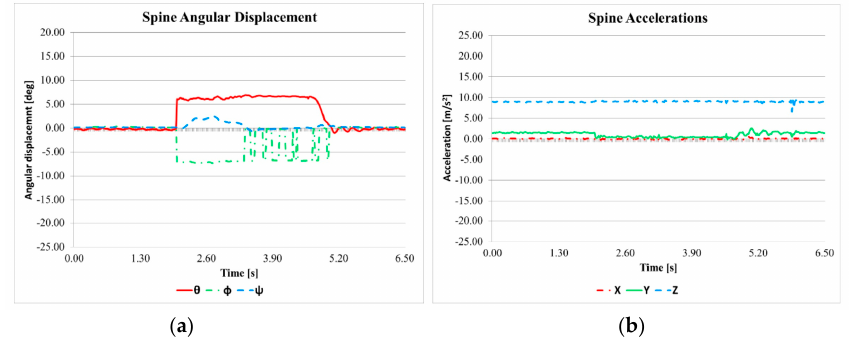
Figure 9. Acquired data from the IMU sensor during the test in Figure 8: ( a ) angular displacements; ( b ) accelerations.